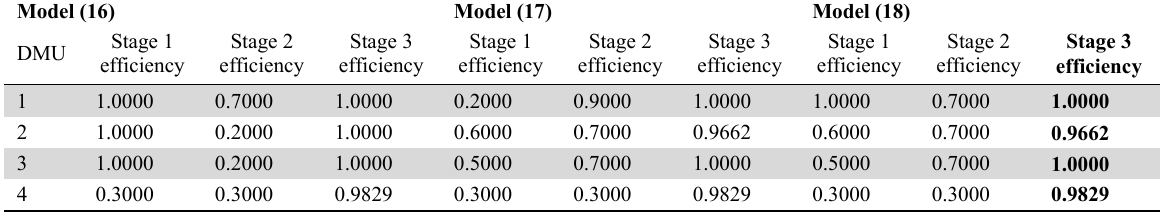
Numerical results for two-stage problems of model 1 with values of (cid:2012)(cid:2009) (cid:3404) (cid:2012)(cid:2010) (cid:3404) 0.1